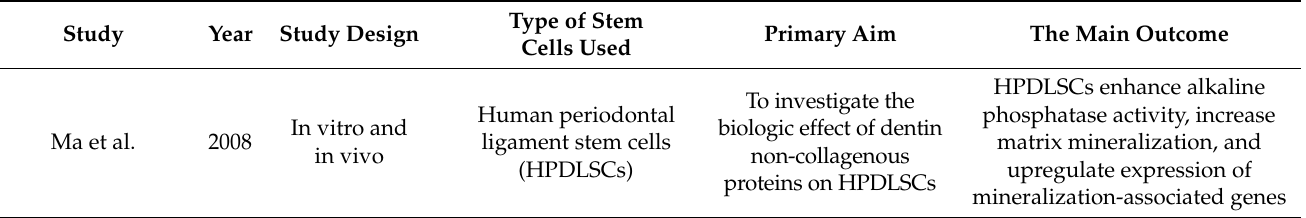
Table 1. The characteristics and selected primary results of in vitro and in vivo studies investigating stem cells (oral and non-oral-derived) reflecting their potential use in regenerative dentofacial